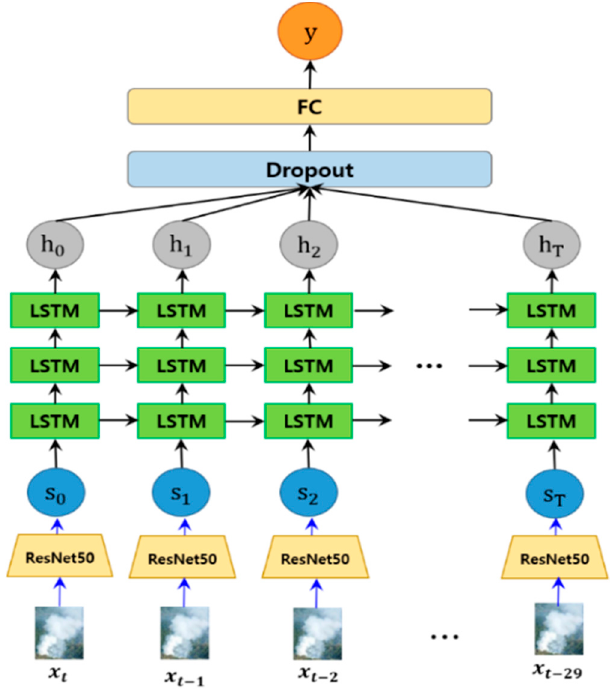
Figure 5. Structure of LSTM consisting of three layers. 30 frames of smoke candidates are applied to the input unit continuously through ResNet50.